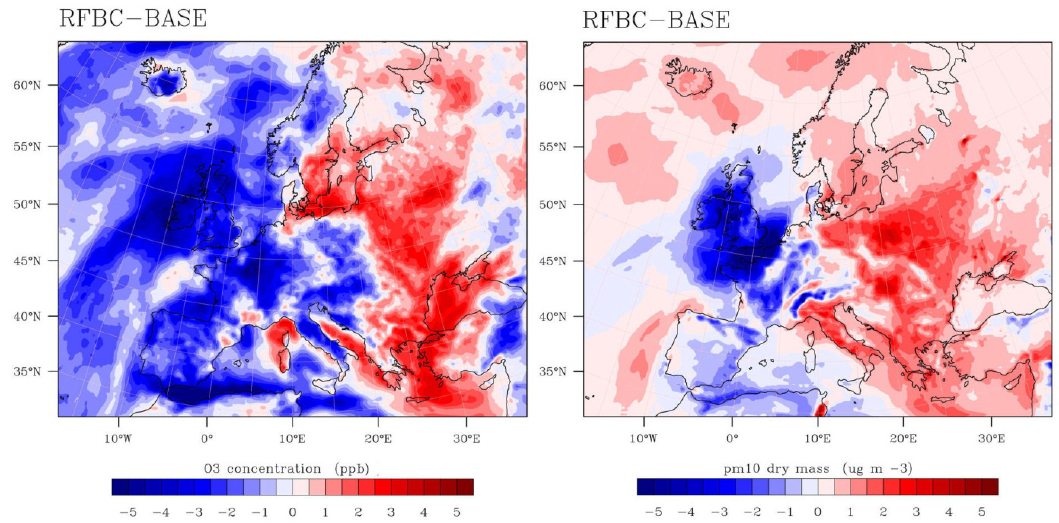
Fig. 5. Differences in ozone (left) and PM 10 (right) concentrations in July 2006 between two WRF-Chem simulations. The BASE simulation does not consider interactions between aerosols and meteorology, whereas the RFBC simulation considers both direct and indirect effects (Adopted from Forkel et al., 2012) .